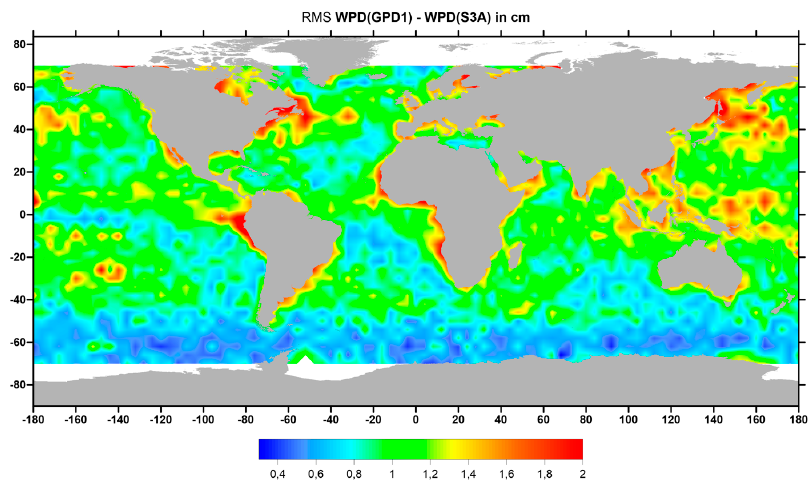
Figure 14. Spatial distribution of the RMS values of the WPD differences (cm) between GPD1 and the S3A MWR, for cycles 05 to 16.